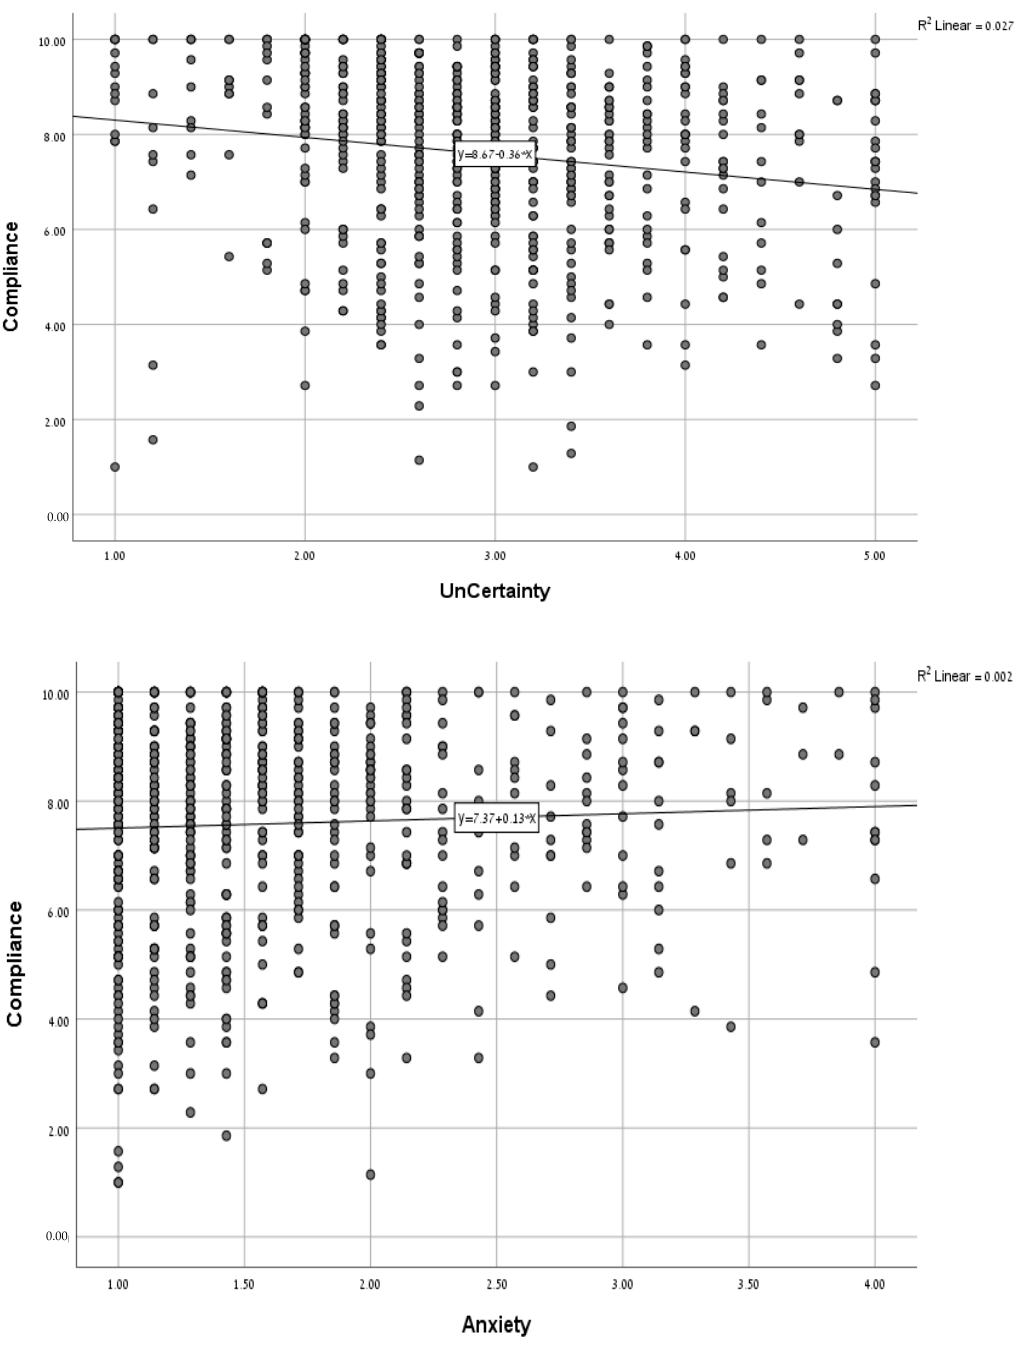
Figure 1. Associations of single factors with the level of intention to comply, continuous variables in Pearson correlation graph.